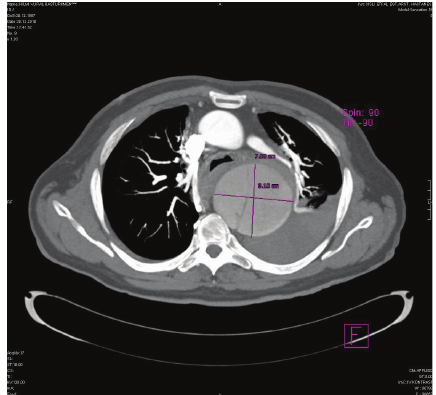
Figure 1: Axial image through thorax, a huge proximal descending thoracic aorta aneurysm with a hypointens intimal flap in it is seen. A perimediastinal hematoma and left pleural e ff usion are also present.